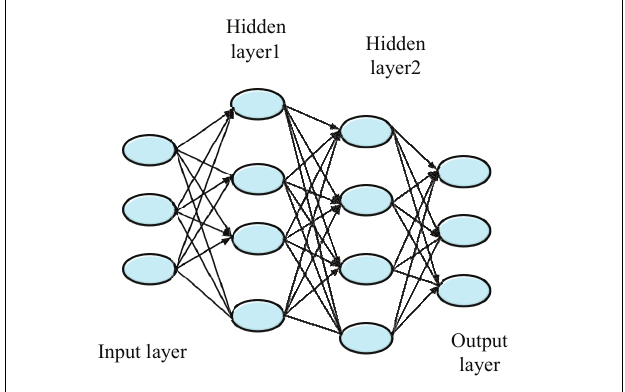
FIGURE 1 | The basic structure of the deep neural network